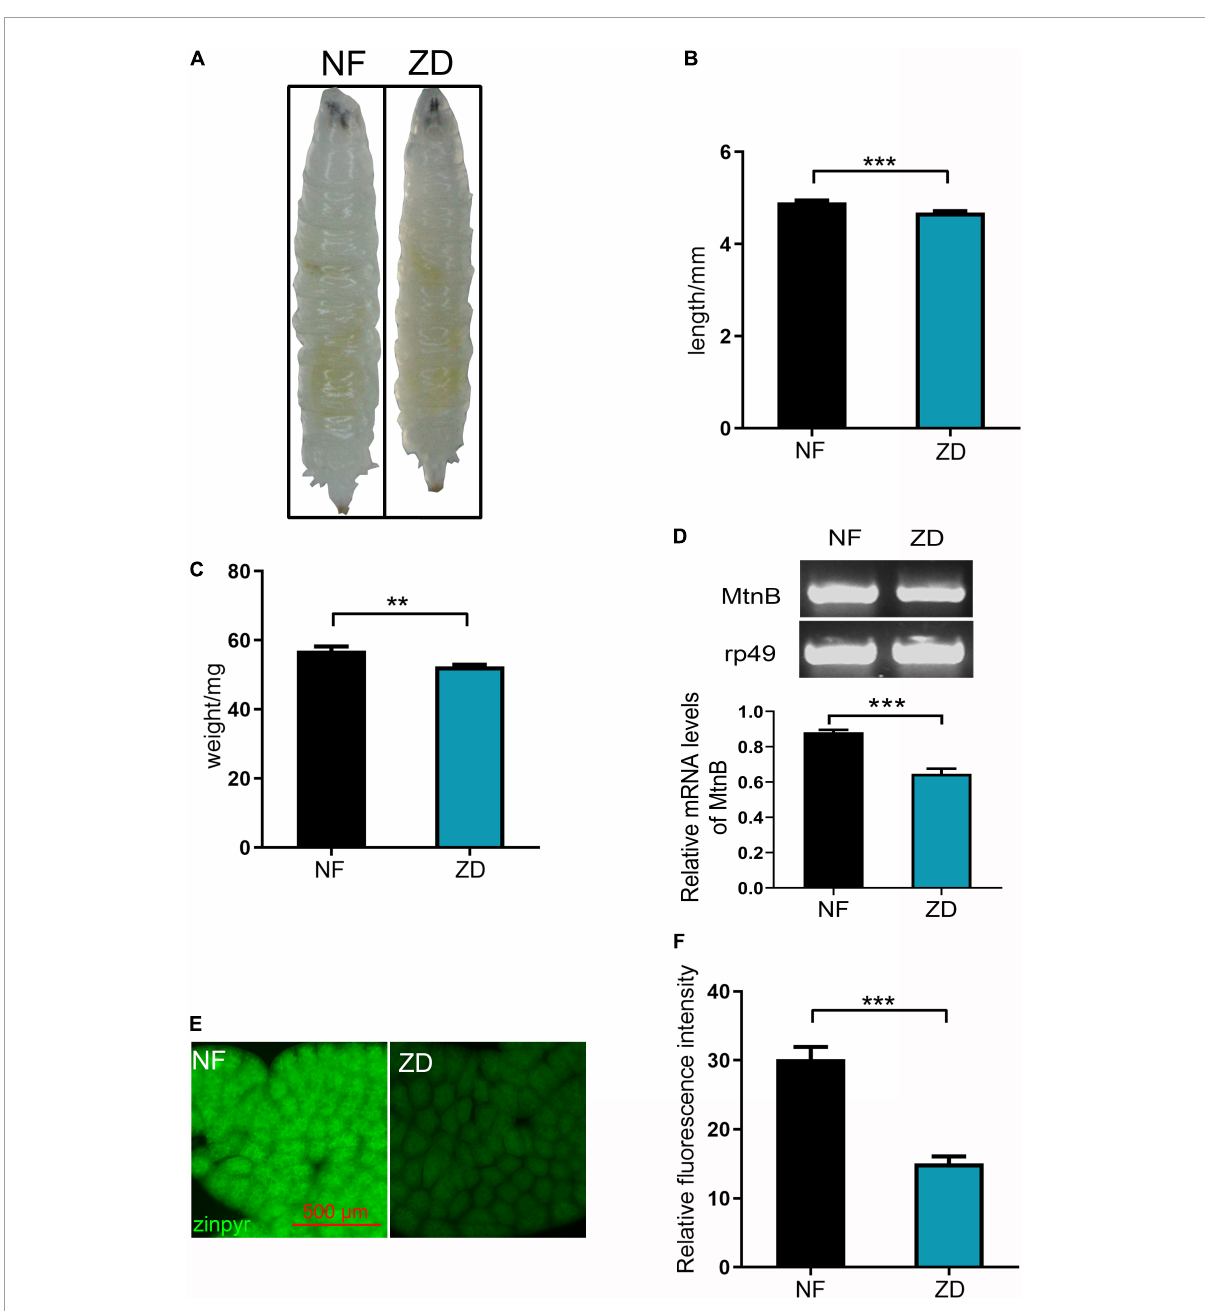
FIGURE3 Establishing an experimental model of zinc deficiency in Drosophila. (A) Compared with the control group, the zinc-deficient third instar larva ( Drosophila zinc deficiency model) is thinner. (B) The body length of the Drosophila zinc deficiency model is shorter than that of the control group, n = 30. (C) The weight of the Drosophila zinc deficiency model is lighter than that of the control group, n = 30. (D) The expression level of Mtnb in the Drosophila zinc deficiency model was decreased, n = 10. (E) Zinpyr-1 staining showed that zinc levels in the fat body of the Drosophila zinc deficiency model was decreased, n = 10. (F) Quantitative measurement of the fluorescent signals in (E) . Data are represented as mean ± SEM of the biological replicates. ** p < 0.01, *** p < 0.001; two-tailed Student’s t